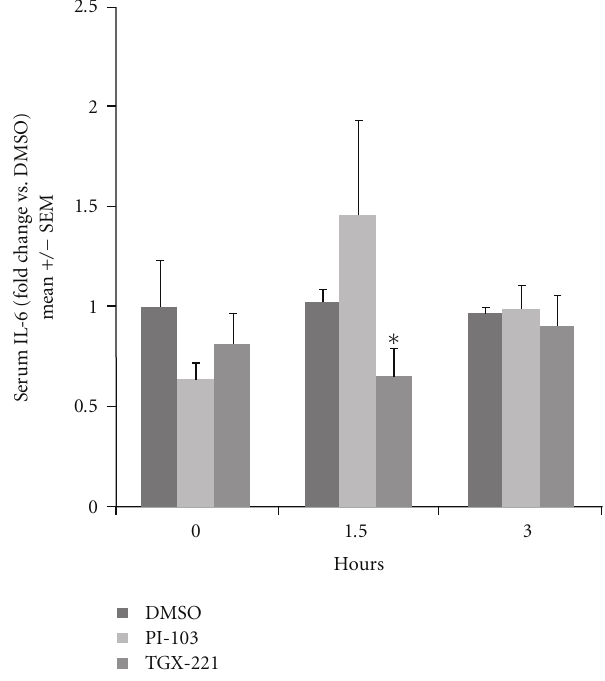
Figure 7: E ff ects of p110 inhibitors on murine responses to flagellin in vivo . Female C57Bl/6 mice (6–12 weeks) were injected intraperitoneally with 200 μ g of TGX-221 or PI-103 in 75% DMSO in PBS, or an equivalent volume of DMSO/PBS. Thirty min later, mice were injected intraperitoneally with 10 μ g of E. coli H18 flagellin in 100 μ l of PBS. Saphenous blood was taken after an addition 90 minutes and 3 hours. Sera were analyzed for IL-6 concentration by ELISA and results expressed as the ratio compared to flagellin plus DMSO control at each time point. Mean serum concentrations of IL-6 in the flagellin plus DMSO vehicle group were 1567 pg/ml at 90 minutes and 4915 pg/ml at 3 hours. N = 4 per group. ∗ P < . 05, TGX-221 versus DMSO, t